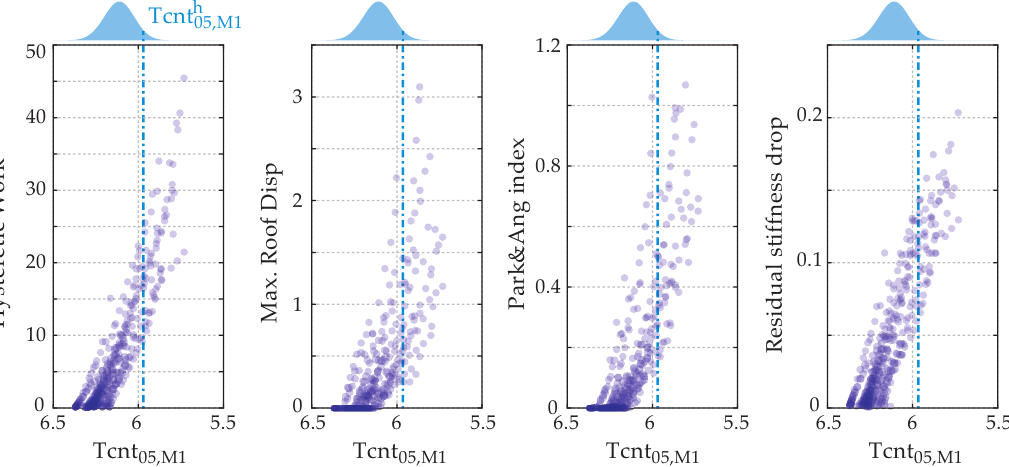
Figure 6. Evaluation of the correlation of the transmissibility-based indicator, Tcnt 05, M 1 , with respect to four EDPs: hysteretic work ( left ), maximum transient roof displacement ( center left ), DI PA ( center right ), and residual stiffness drop ( right ). While a good correlation and an almost linear relation with respect to hysteretic work and residual stiffness drop can be observed, damage detection is undermined by the large variance in the healthy reference